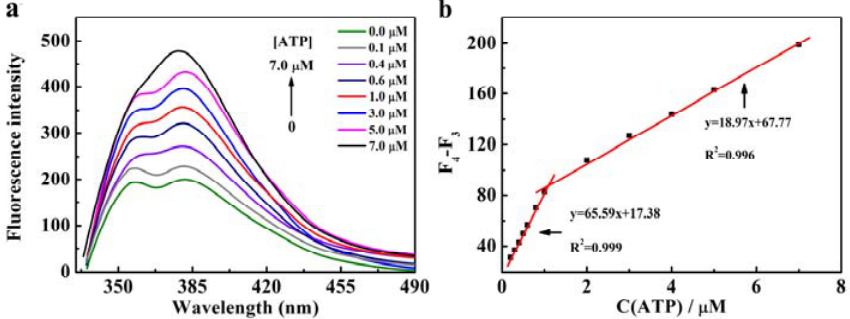
Figure 4. Fluorescence responses to different concentrations of ATP ( a ) and corresponding linear ranges ( b ). The concentrations of CNDs, H 2 O 2 and Cu 2+ were 0.014 mg/mL, 5 mM and 600 nM, respectively .